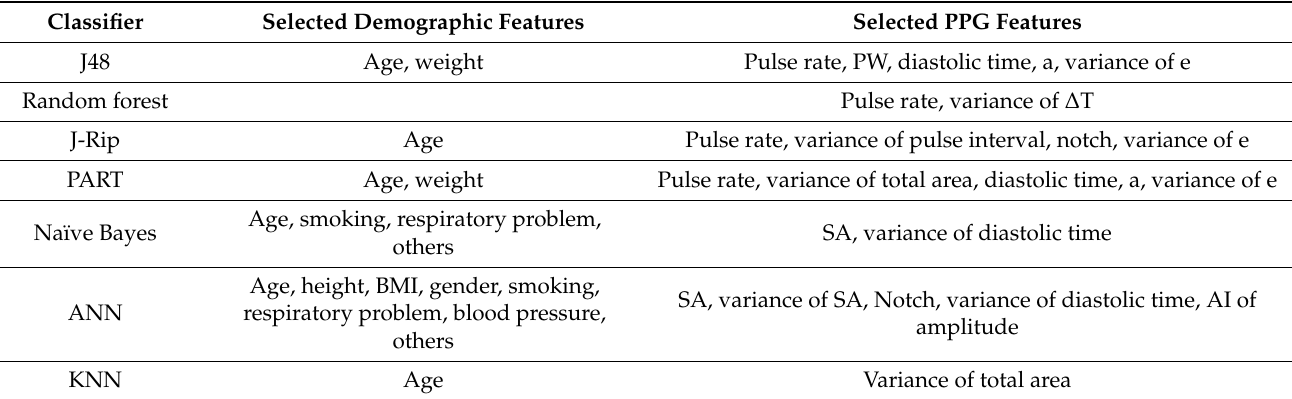
Table 2. Selected features by each classifier in the first